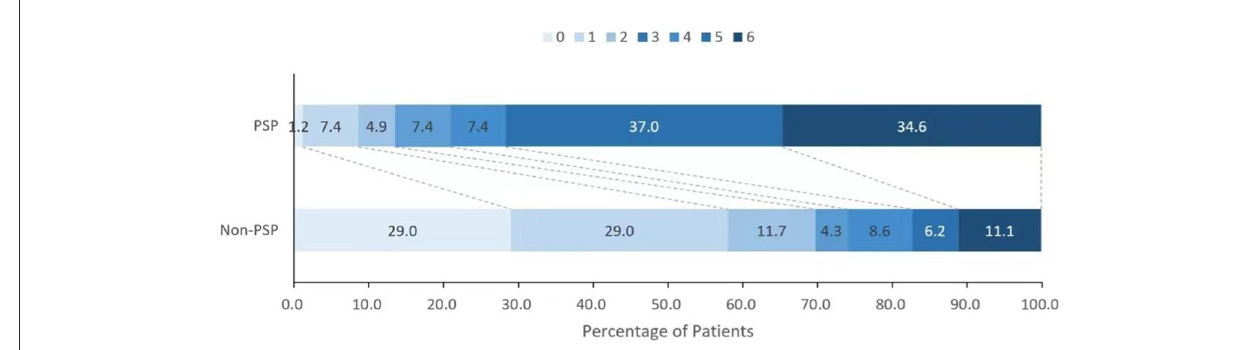
FIGURE2 Distribution of the modified Rankin scale scores between patients with and without poststroke pneumonia.